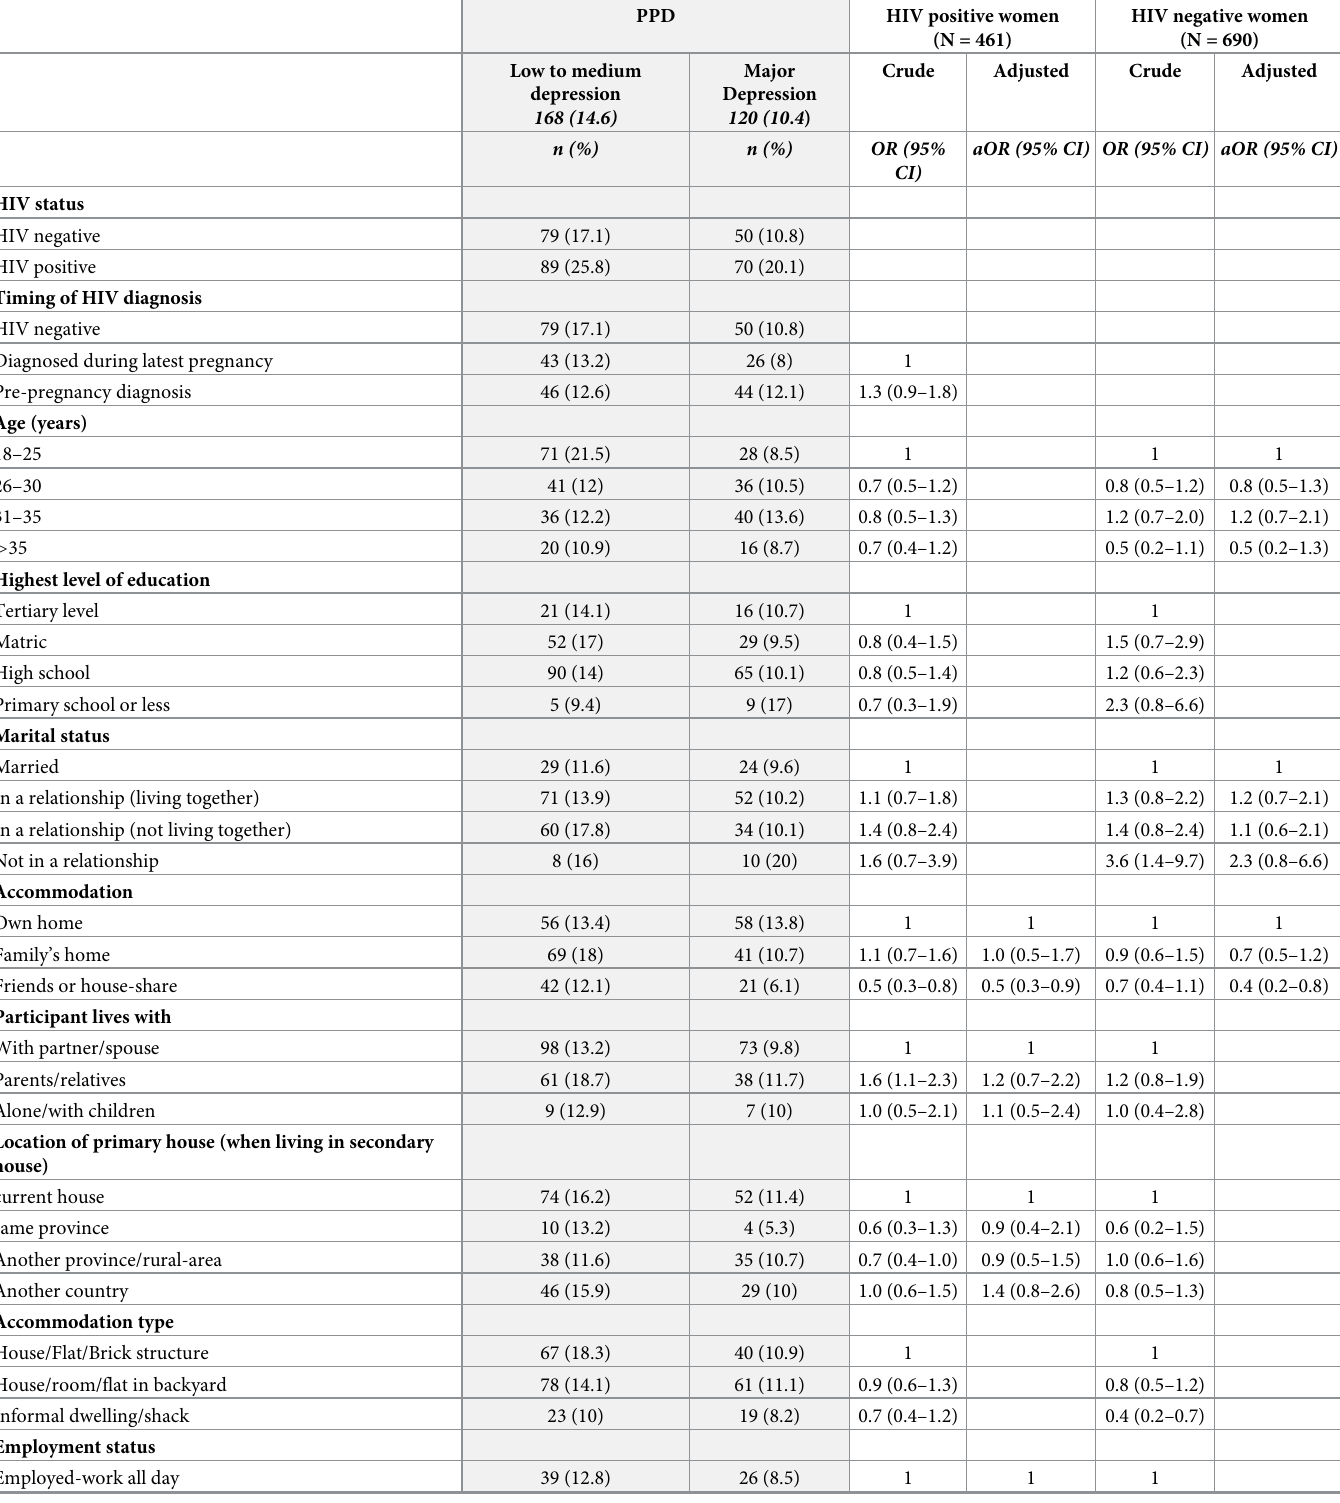
Table 2. Predictors of postpartum depression by HIV